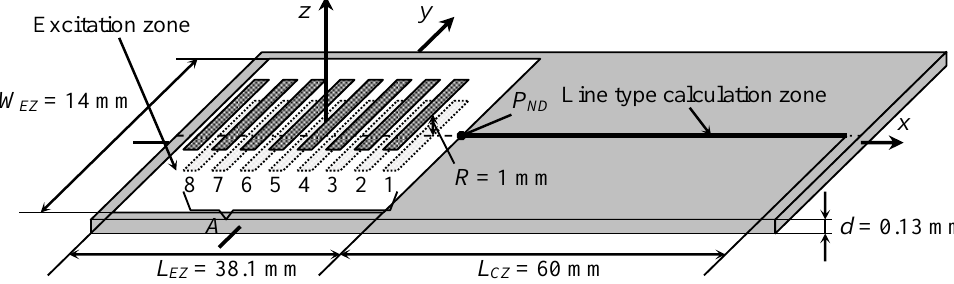
Figure 8. Schematic diagram of air-coupled Lamb wave excitation using planar phased array A.